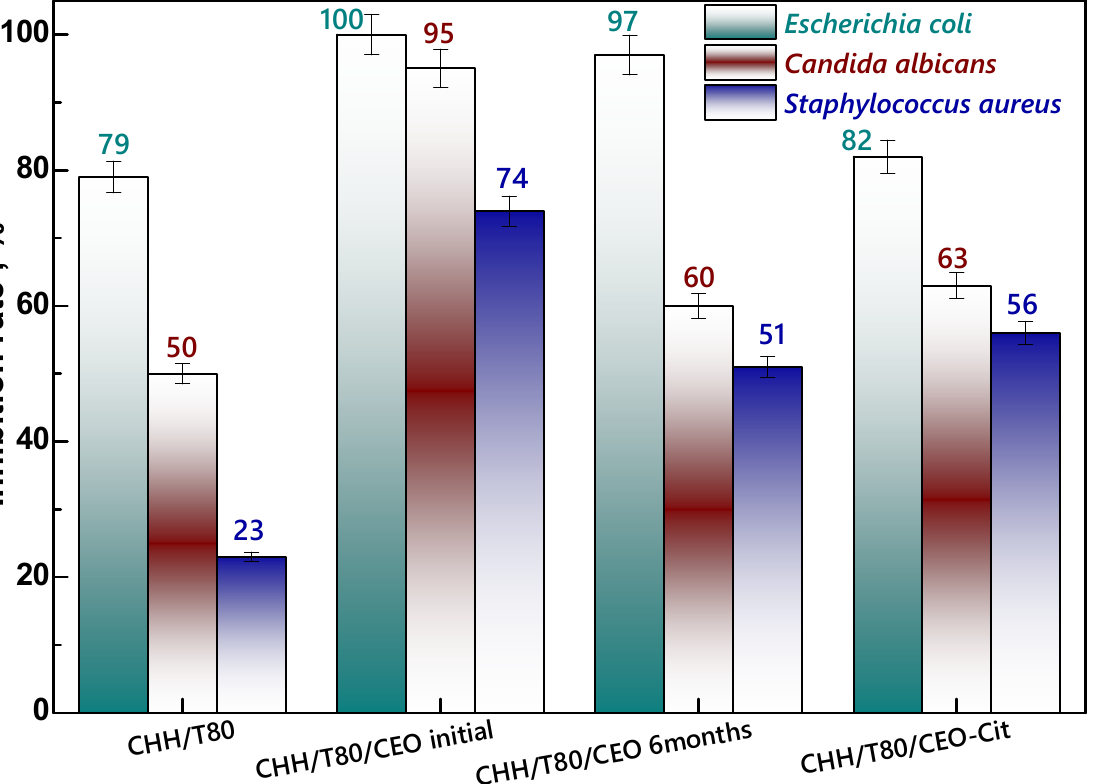
Figure 11. Antimicrobial activity of xerogels: unloaded chitosan (CHH/T80), clove essential oil (CEO) loaded freshly prepared (CHH/T80/CEO initial) and after 6 months storage (CHH/T80/CEO 6 months), and citrate cross-linked (CHH/T80/CEO-Cit).